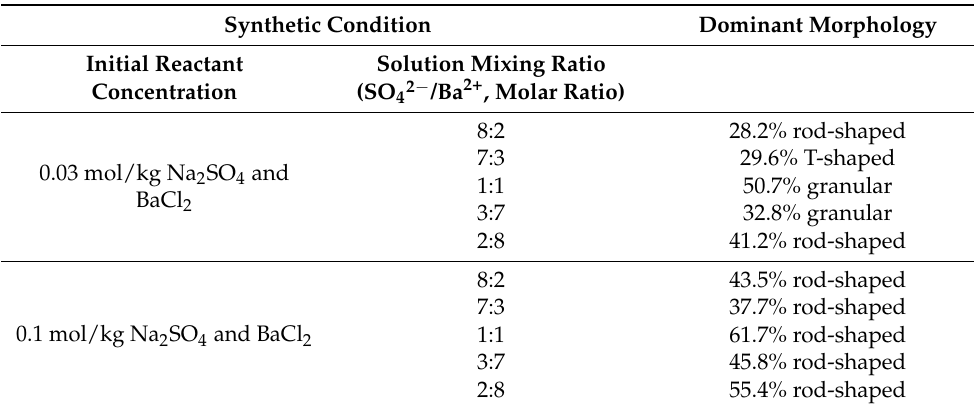
Table 4. Dominant morphology of barite synthesized by in-situ mixing of Na 2 SO 4 and BaCl 2 solutions with different concentrations and mixing ratios at 200 ◦